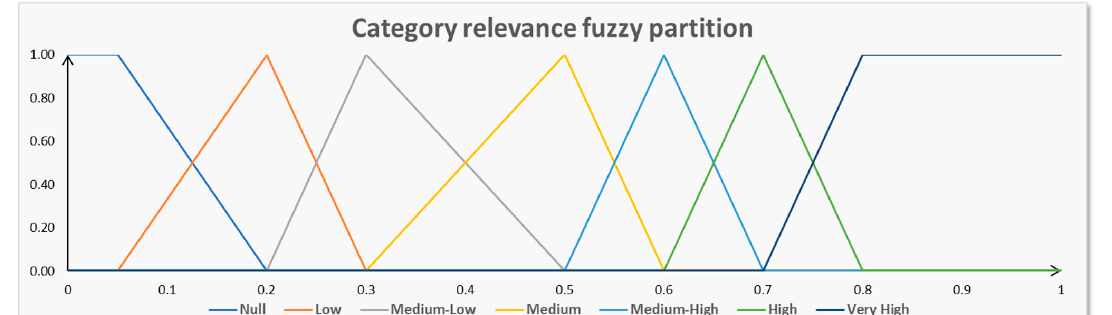
Figure 5. Category relevance fuzzy partition.